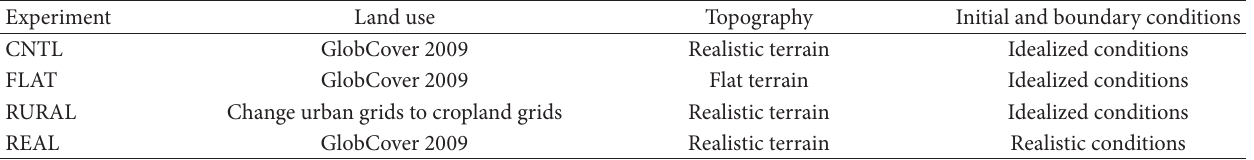
Figure 1: (a) The topography height of the nested domains and (b) the land use category of the inner domain. The rectangle in (a) indicates the location of inner domain. The solid line in (b) indicates the route of the vertical cross section made from point A to point B given in Figures 6–8 and Figures 11–15, and the point O located at the border of land and sea is used as the reference point (0,0) in the vertical cross section. The black dots in Figure 1(a) indicate the location of the five meteorological stations used to validate the WRF simulation. Table 2: Summary of the numerical